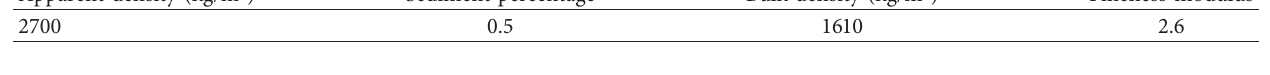
Table 3: Coarse aggregate.